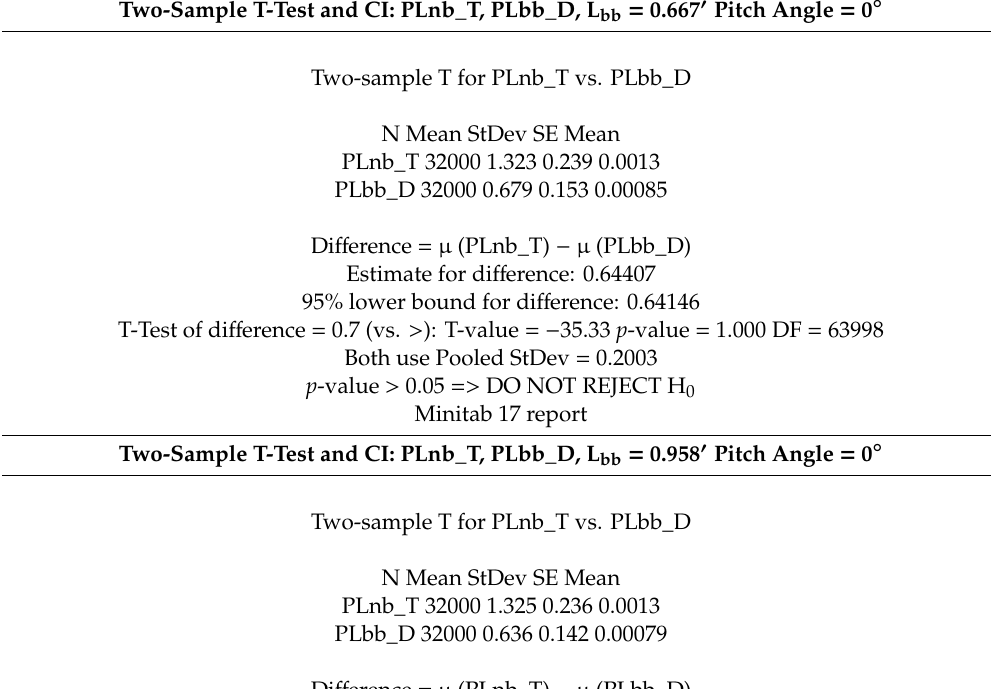
Table A1. Hypothesis testing: PL nb vs. PL bb